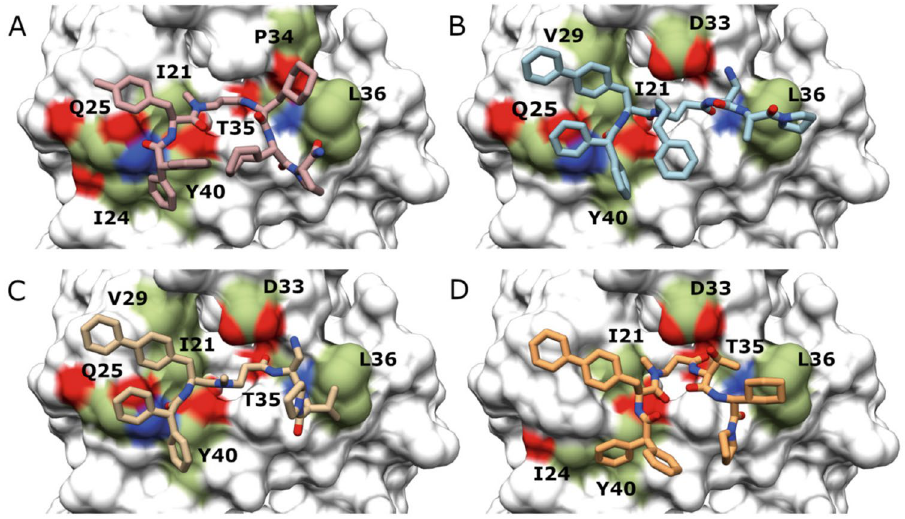
Figure 4. Peptidomimetic in silico improvement. In silico predicted binding modes of ( A ) P1.1, ( B ) P1.2, ( C ) P1.3 and ( D ) P1.4. Contact point residues on the RAS surface (PDB code 5P21) are shown in colour on the RAS protein surface: aliphatic areas are shown in green, areas with amino groups in blue and areas containing carboxylic moieties in red. RAS residues involved in contact with the compounds are named using the one letter amino acid code; the residue number is shown next to the letter. Images were drawn using the docking program indicated in